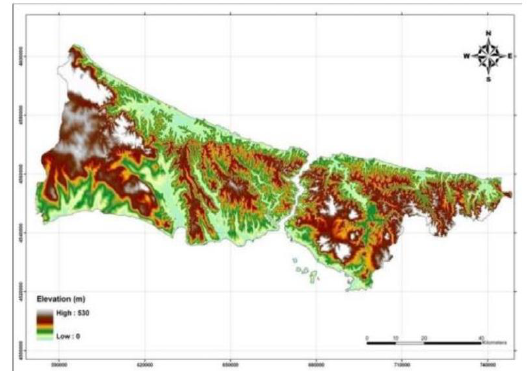
Figure 1: Istanbul and the Bosphorus strait.